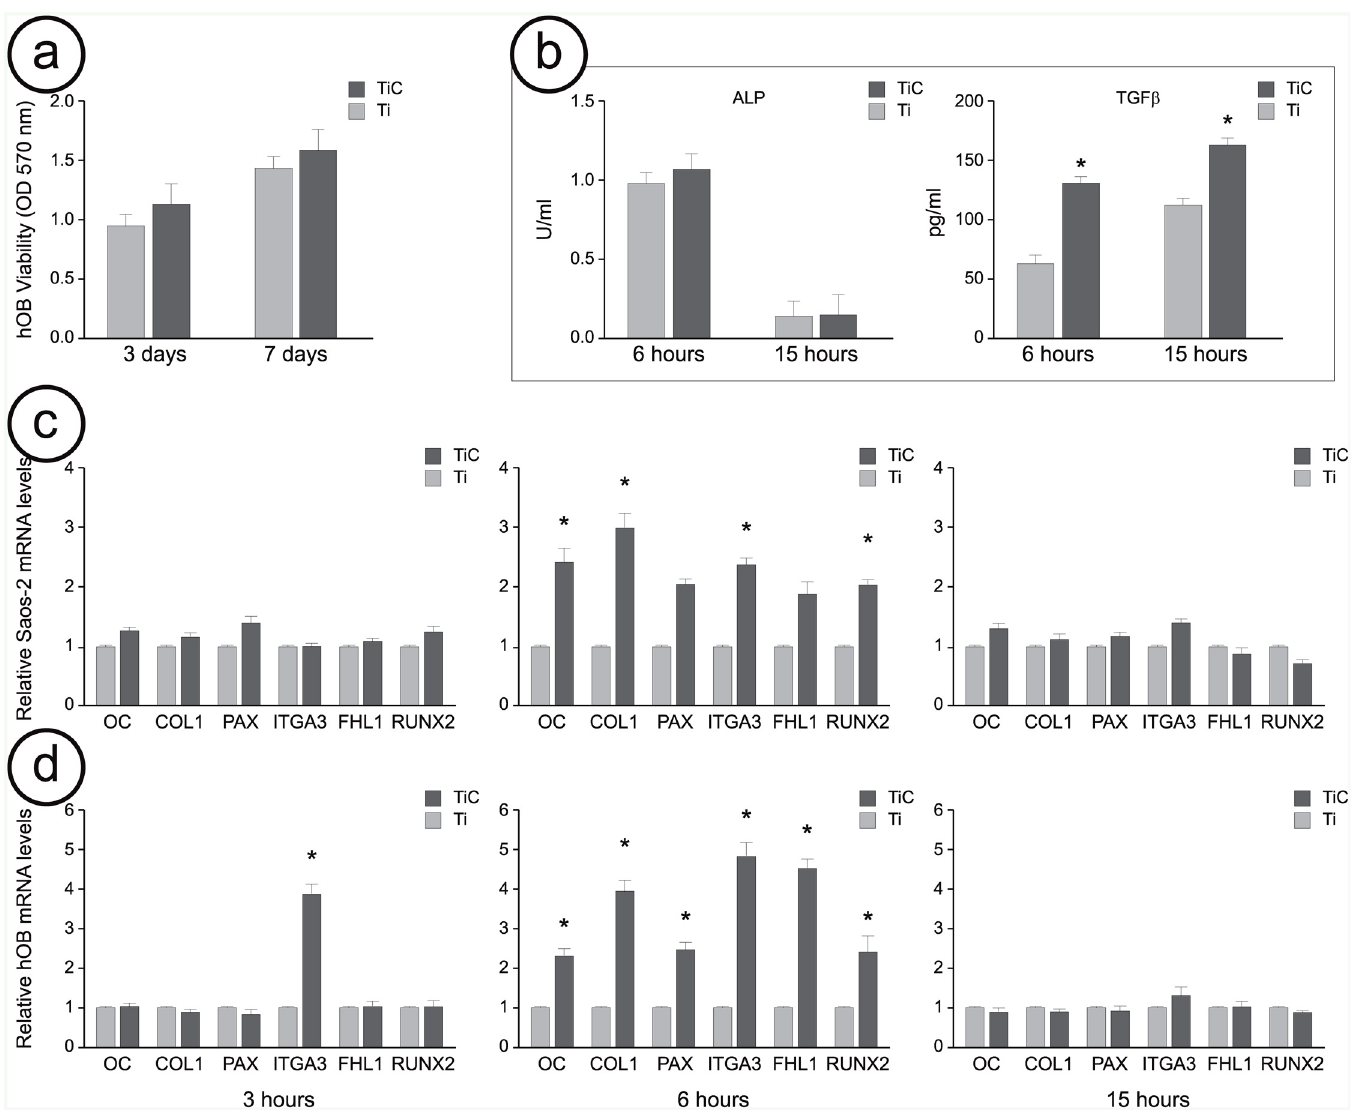
Fig 2. Viability, ALP and TGF β 1 production and gene expression of osteoblast cells cultured on uncoated and TiC coated titanium disks. Panel a: Cellular viability, assessed by MTT (3-[4,5-dimethylthiazol-2-yl]-2,5-di-phenyltetrazolium bromide) method. The human primary osteoblasts (hOB) (2 x 10 4 ) were cultured for 3 and 7 days on uncoated titanium (Ti) disks (light grey bars) and on disk coated with nanostructured TiC layer (dark grey bars). Formazan extracted from cultures was determined spectrophotometrically at 570 nm. Panel b: ALP activity was quantitatively determined by colorimetric assay into cell lysate and TGF β 1 was quantitatively determined by ELISA into culture medium obtained from hOB cultured on uncoated Ti and on TiC coated disks. Panel c : Gene expression of osteocalcin (OC), collagen1a2 (COL1), paxillin (PAX), integrin α 3 β 1 (ITGA-3), Four and Half LIM domains protein (FHL1) and Runt related transcription factor 2 (RUNX-2) obtained from the mRNA extracted from Saos-2 cells cultured 3, 6 and 15 hours on uncoated Ti and on TiC coated disks and analyzed by Q-RT-PCR. Panel d : Same analysis on mRNA obtained from hOB. All the presented results are reported as relative mRNA levels and expressed as fold change compared to mRNA extracted from cells cultured on uncoated titanium disks. Results represent the mean +/- Standard Error of the mean of data obtained by five independent experiments, performed using five cell samples, and each sample was analyzed in triplicate with a standard deviation among triplicate ranging between 0,38 and 0,04. * Indicates P-value < 0.05.